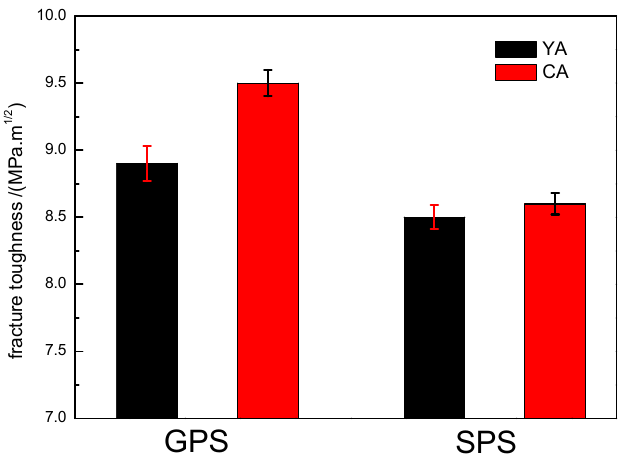
Figure 6. Fracture toughness (MPa · m 1 / 2 ) of GPS and SPS sintered silicon nitride samples.